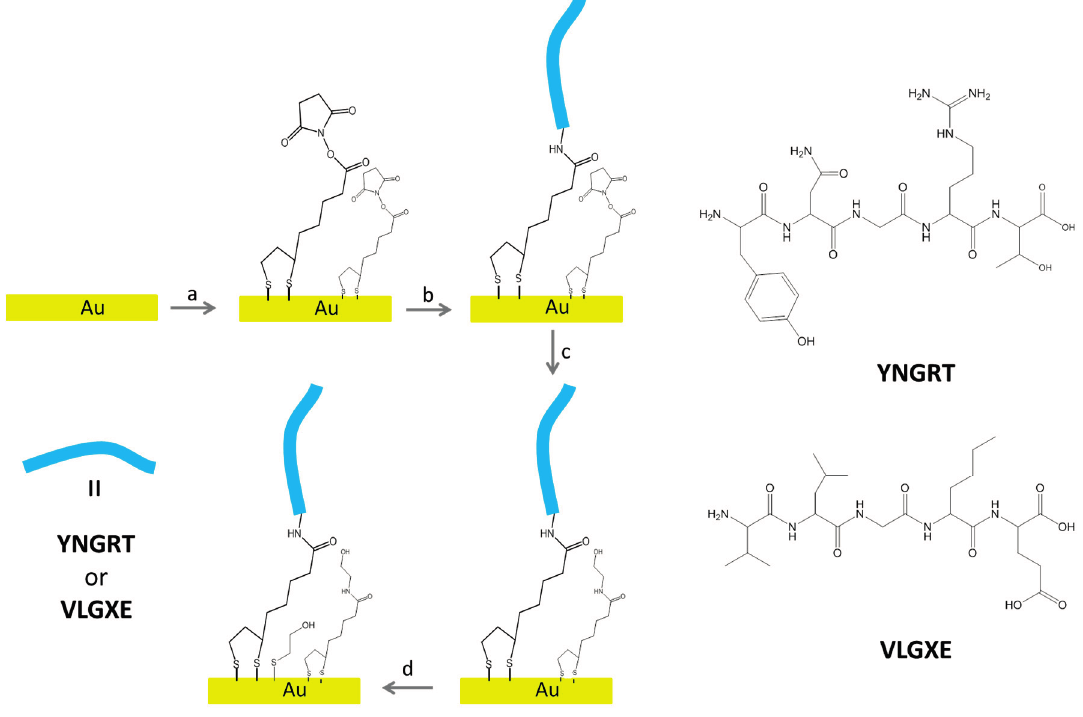
Figure 1. Stepwise procedure for covalent immobilization of peptide (YNGRT or VLGXE) on Au: ( a ) Lipoic acid N-hydroxysuccinimide ester (Lip-NHS); ( b ) peptide in 10% acetonitrile (YNGRT or VLGXE); ( c ) ethanolamine; ( d )